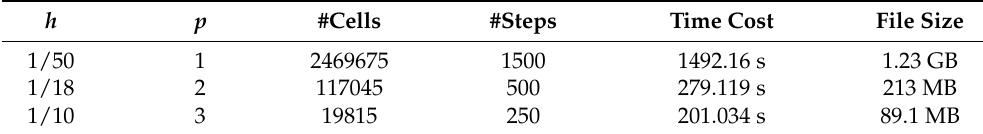
Table 1. Comparison between time costs and file sizes of various h – p